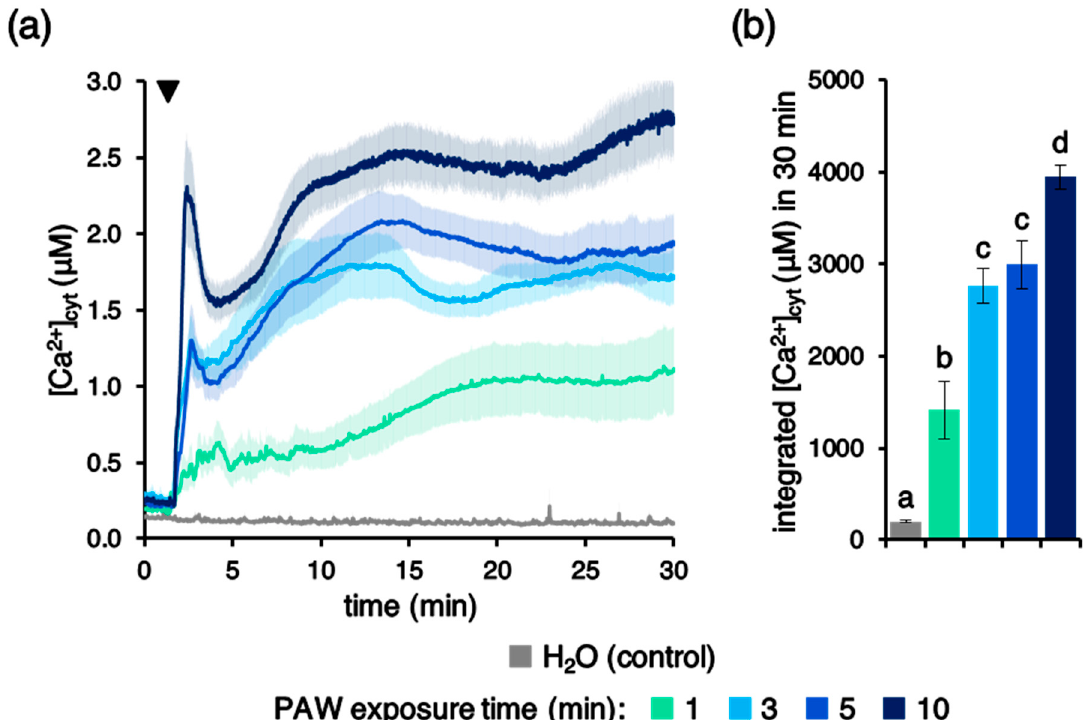
Figure 1. Monitoring of changes in cytosolic Ca 2+ concentration ([Ca 2+ ] cyt ) induced by plasma-activated water (PAW) in Arabidopsis thaliana (Arabidopsis). Ca 2+ measurement assays were conducted in Arabidopsis seedlings stably expressing aequorin in the cytosol. Seven-day-old intact seedlings were challenged with 1:2 dilutions of different PAWs, obtained by exposing deionized H 2 O to cold plasma (generated at 900 W power, torch #1) for different time intervals: 1 min (green), 3 min (light blue), 5 min (blue), or 10 min (dark blue). Untreated deionized H 2 O was administered to control samples (grey). ( a ) Data are the means (solid lines) ± SE (shading) of six seedlings derived from three independent growth replicates. The arrowhead indicates the time of stimulus application (at 100 s); ( b ) statistical analyses of integrated [Ca 2+ ] cyt dynamics over 30 min. Bars labelled with different letters differ significantly ( p < 0.05, Student’s t test).